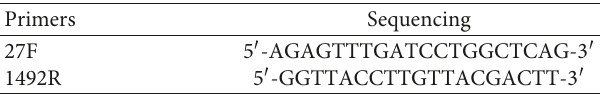
Table 3: Primers sequencing to employ for PCR experiments to characterize halophilic